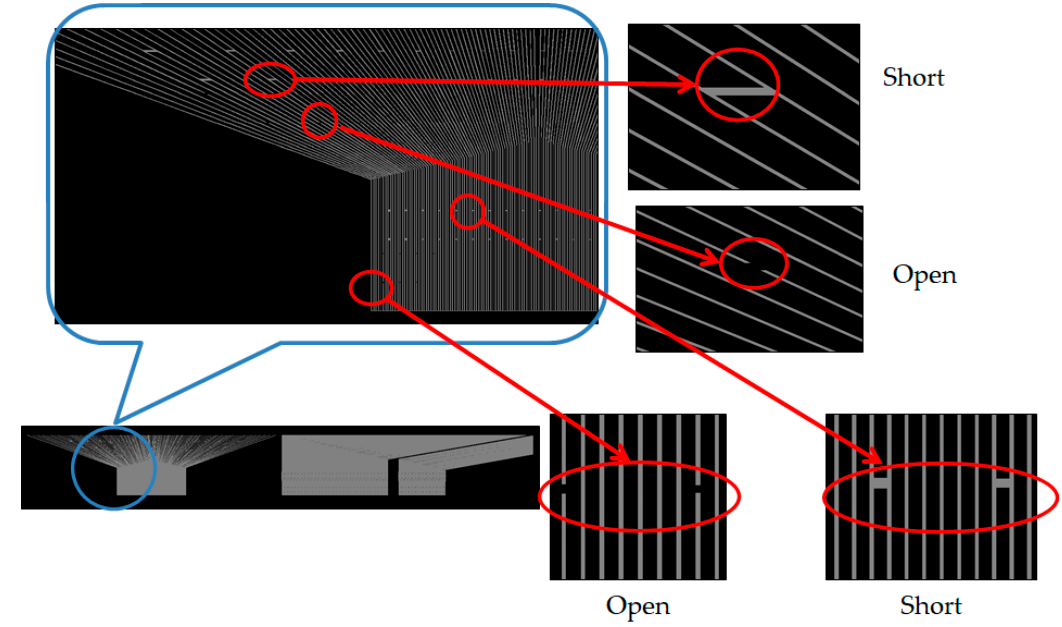
Figure 12. Illustration of the line scan at open and short defects on the left side of the photomask.